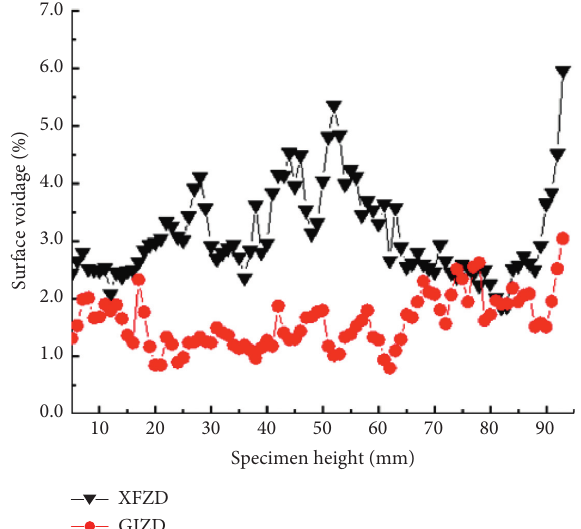
Figure 14: The variation coefficient of the coarse aggregate area ratio under static compaction.